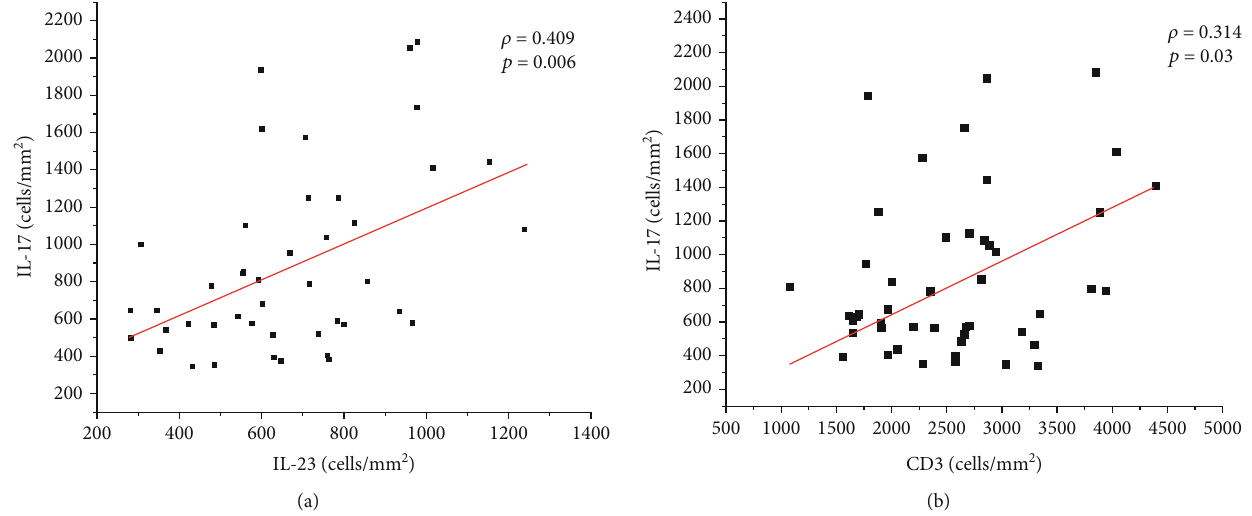
Figure 3: Graphs showing the correlation between the cellular density of IL-17 + cells and IL-23 + cells (a) and CD3 + cells (b). The value of ρ is Spearman ’ s correlation coe ffi cient, and p is the p value. The red line indicates a positive